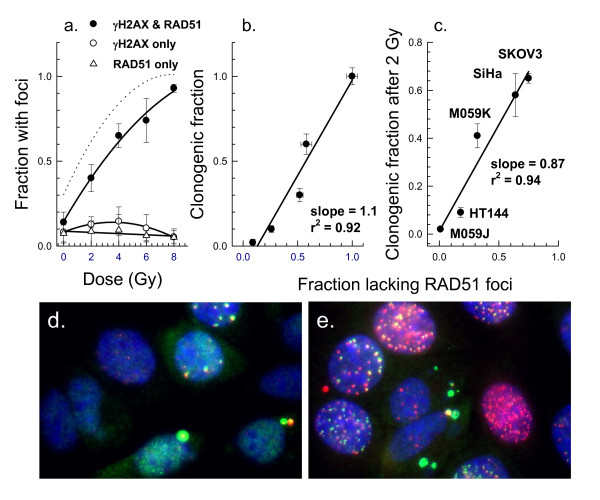
The fraction of cells with residual RAD51 foci is correlated with the fraction of cells that die. Panel a: SiHa cells were exposed to X-rays and allowed to recover for 24 hours. Cells were fixed and co-immunostained for γH2AX and RAD51, and cells with foci were scored. Results are the means and SD for 3 experiments. Panel b: The fraction of SiHa cells lacking RAD51 foci is compared with the clonogenic fraction measured 24 hours after exposure to X-rays. Panel c: Several cell lines were exposed to 2 Gy, allowed to recover for 24 hours, and then examined for the fraction of cells that lacked RAD51 foci. Panel d: RAD51 (green) and γH2AX (red) antibody staining of SiHa cells 24 hours after exposure to 2 Gy. Nuclei are stained blue with DAPI. Panel e: 24 hours after exposure to 8 Gy. Note the micronuclei stained with antibodies to RAD51 and/or γH2AX foci and the co-localization of some foci in some cells but not all cells.